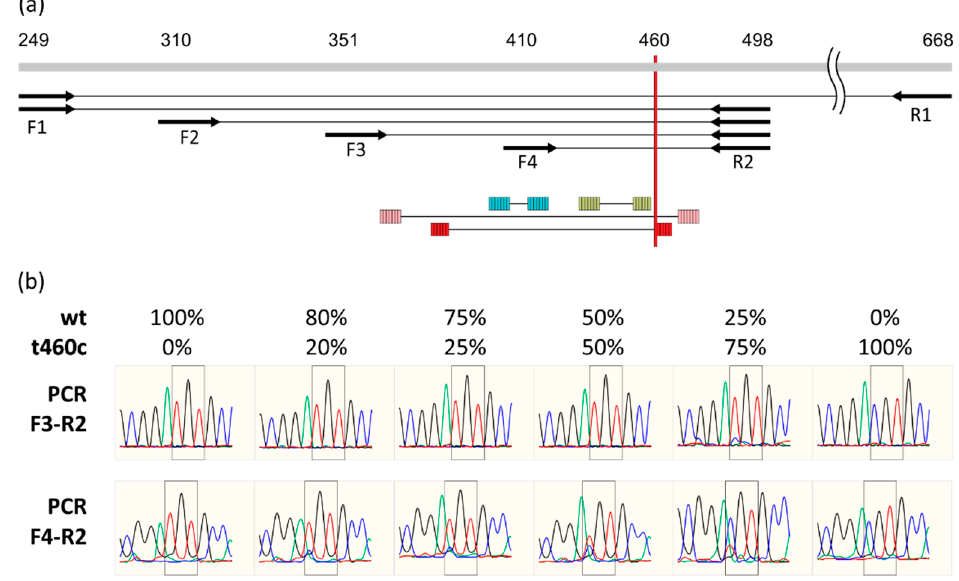
Figure 1. Amplification and sequencing of the rplC locus. ( a ) Positions of primer binding sites and DNA secondary structure, the additional stem forming due to t460c mutation is shown with red. ( b ) Sequencing chromatograms with artificial mixes of wild-type and mutant genomic DNA in various ratios.